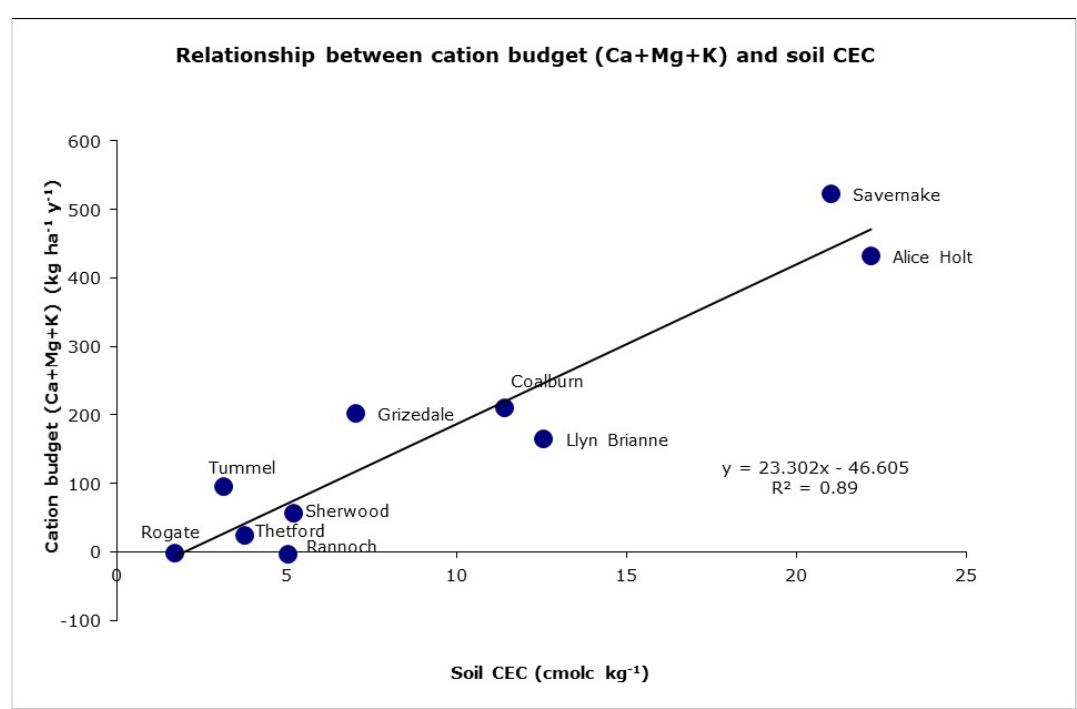
Figure 4. Linear relationship between total base cation (Ca+Mg+K) budget and soil cation exchange capacity (CEC) at the ICP Forest Level II monitoring sites ( n = 10, r 2 = 0.89, p < 0.001). Table 3. ICP Forest Level II site-specific input and output base cation (Ca, Mg and K) fluxes (kg ha − 1 y − 1 ) based on >10 years long term monitoring datasets: average annual flux for each base cation ( a ) and expressed as a proportion (%) of the total ( b ). The Level II sites were not thought to have been fertilised, while the age and/or nature of the woodland plus management made it less appropriate to include base cation inputs from the pre-existing vegetation or enhanced leach- ing by clearfelling. However, these processes are included in the harvesting scenarios presented in Figures